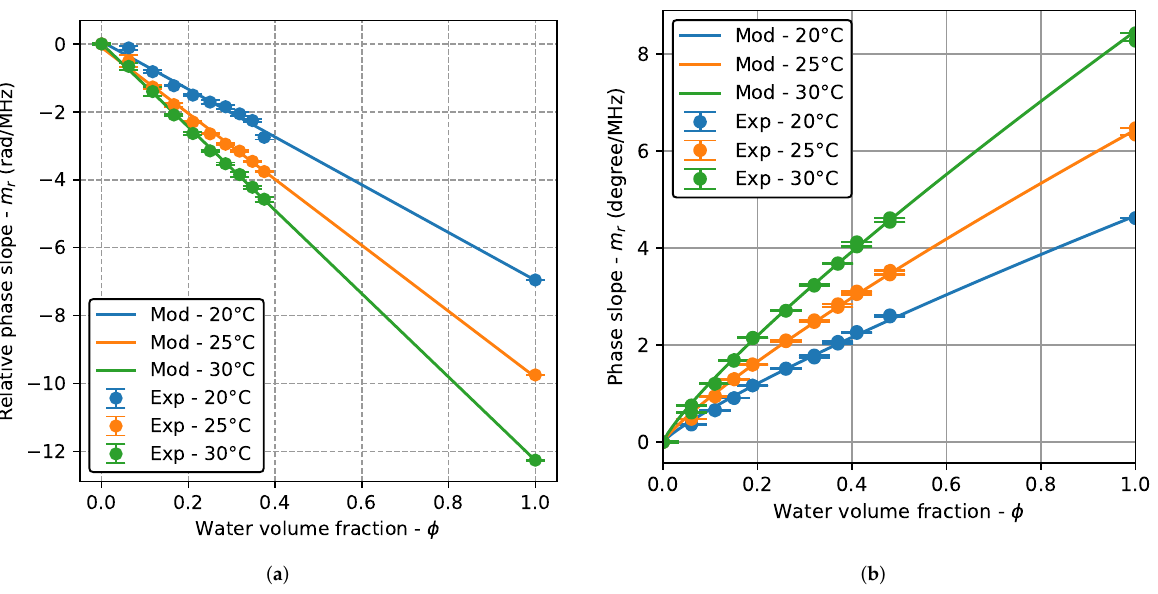
Figure 5. Relative phase slope as a function of the water volume fraction for the three test tempera- tures: transmission–reception (TRD) and backscattering (BSD) cases. Experimental results are the mean and standard deviation of 50 acquisitions and the solid lines are the fitting results. In the BSD case, two identical tests performed at each temperature are shown. ( a ) TRD. ( b ) BSD. The monotonic behavior with a small standard deviation allows the adjustment